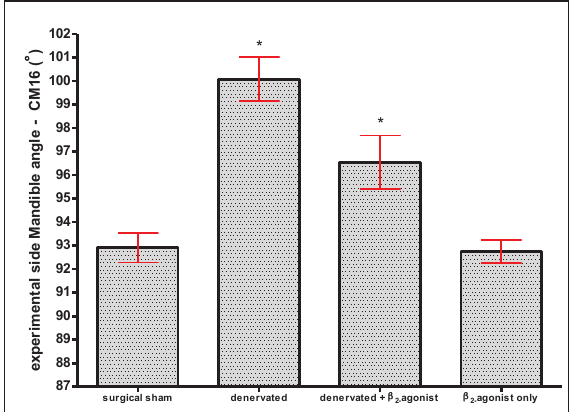
Figure 5. Mean measurement for CM 16 for the four study groups. Left hemi-mandibular angle. * p < 0.05 = significant difference compared to Surgical